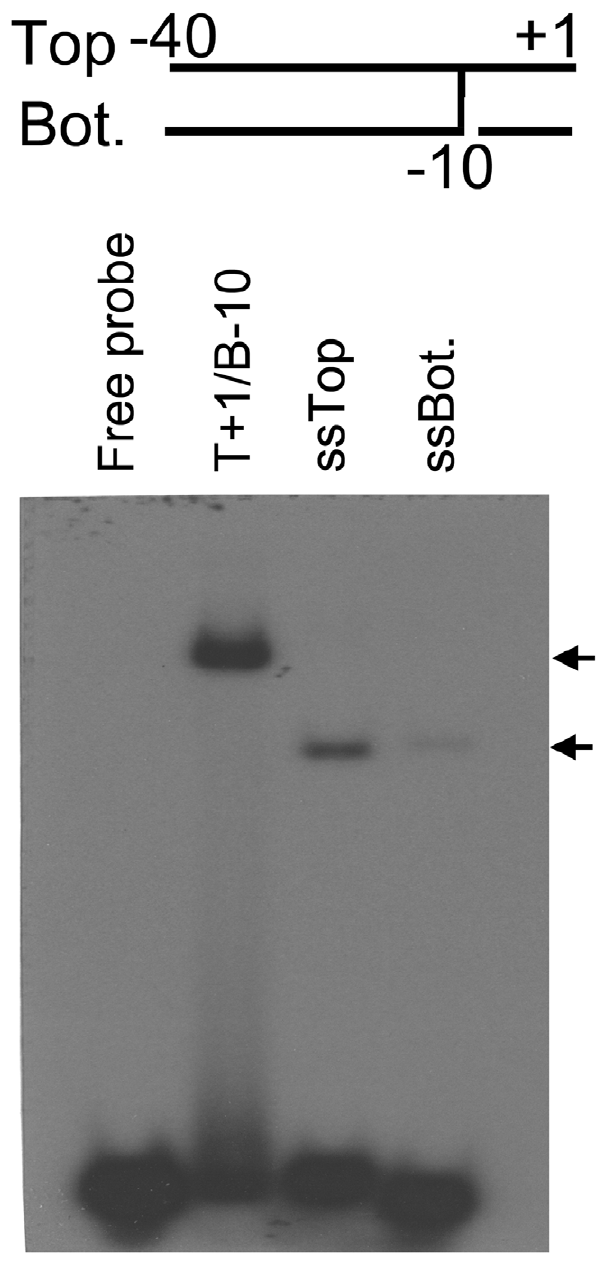
Figure 3. The interaction between Tt-RpoE1 and different promoter DNA structures. The structure of parental probe is provided at the top. EMSA results of 5 m M Tt-RpoE1 protein binding with single-stranded (ssTop, ssBot.) or fork-junction structure promoter DNA(T + 1/B 2 10); the vertical line indicates the terminal base-pair on the strands used in fork-junction probe. Free probe (T + 1/B 2 10) was loaded as a negative control. The arrows indicate complexes formed by Tt- RpoE1 and the different probes. doi:10.1371/journal.pone.0040885.g003 (ssTop, Fig. 3), which implied that the double-stranded 2 35 element is also important for Tt-RpoE1 binding to promoter DNA. Notably, a much weaker band formed by Tt-RpoE1 and the template strand (ssBot., Fig. 3) was also found at the same position. These results clearly indicated that Tt-RpoE1 could efficiently bind to the Tt-rpoE1 promoter, consistent with the result